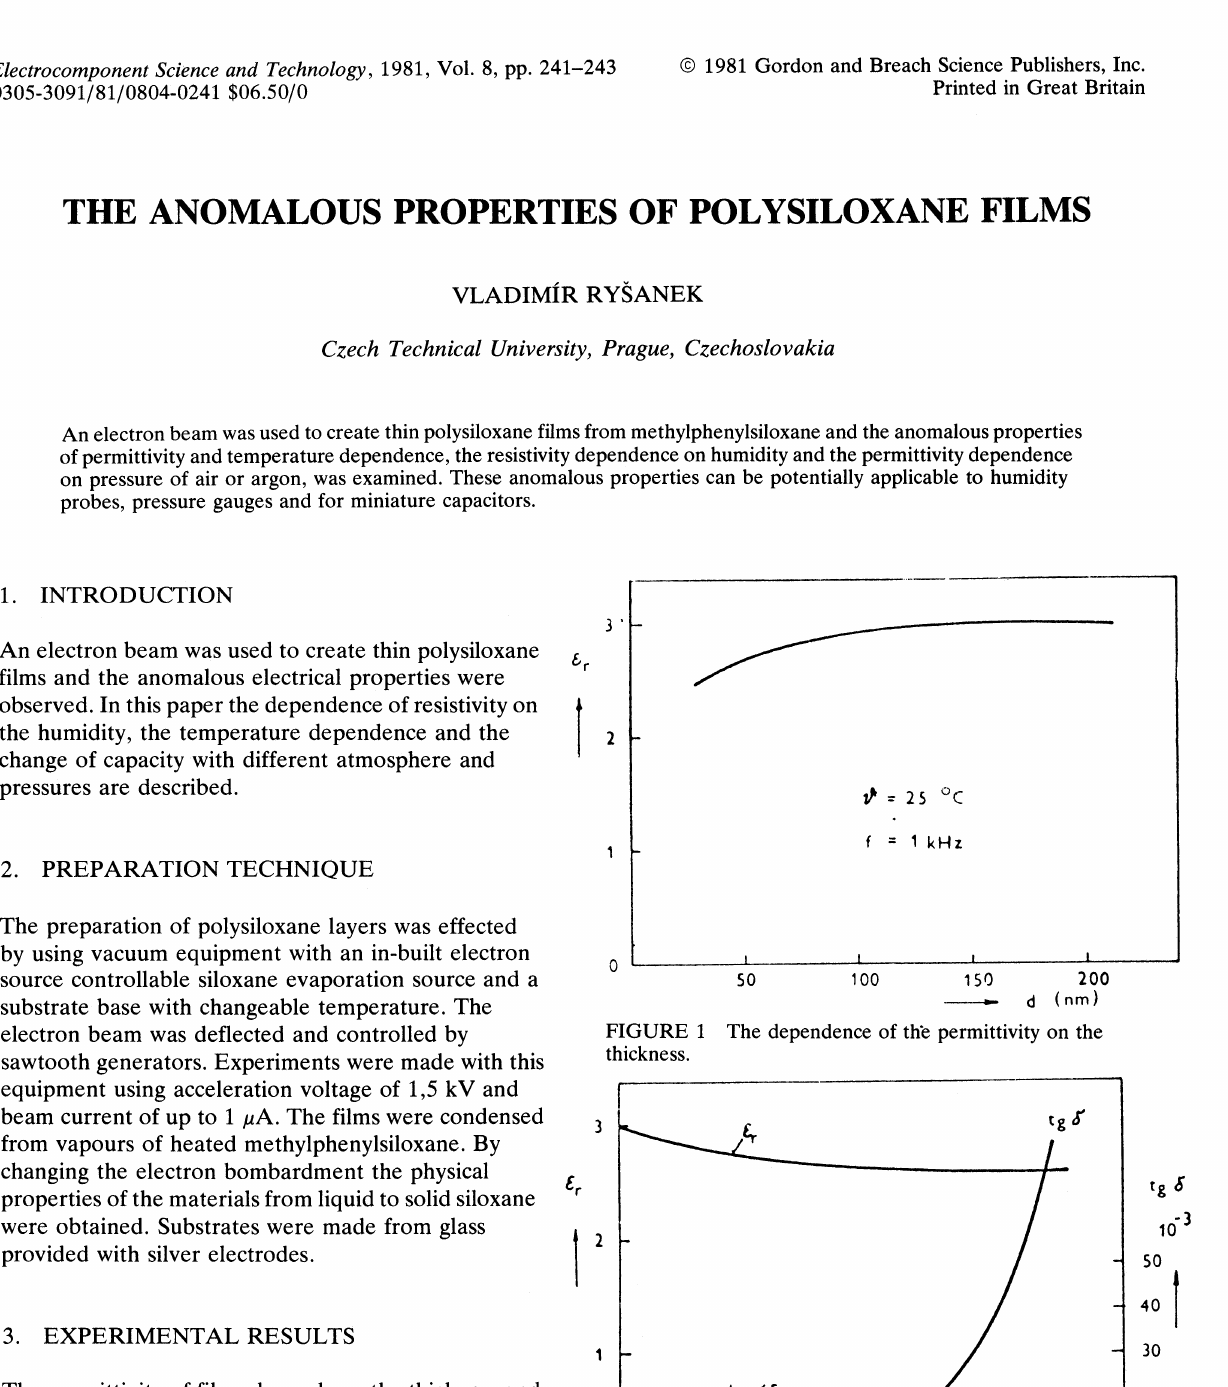
FIGURE 2 The dependence of the er and tg 6 on the